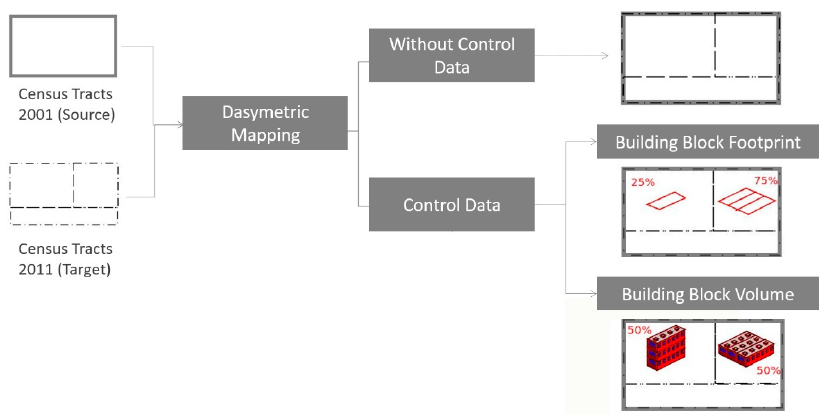
Figure 4. Summary flowchart.